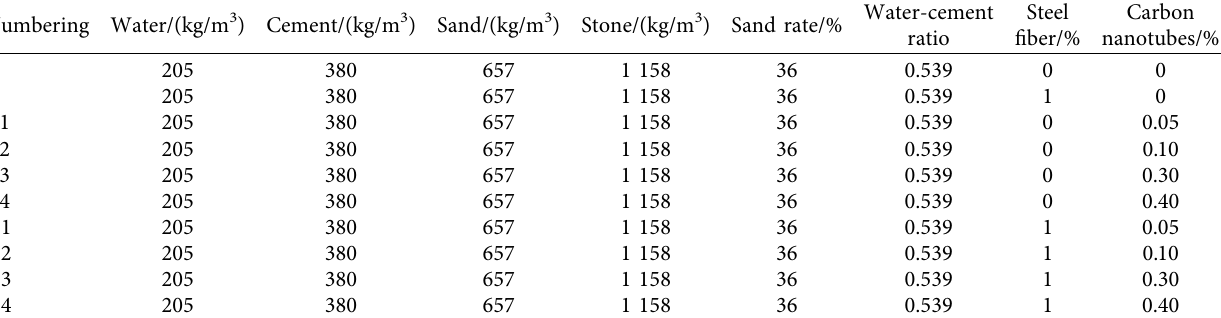
Table 2: Test mix ratio.